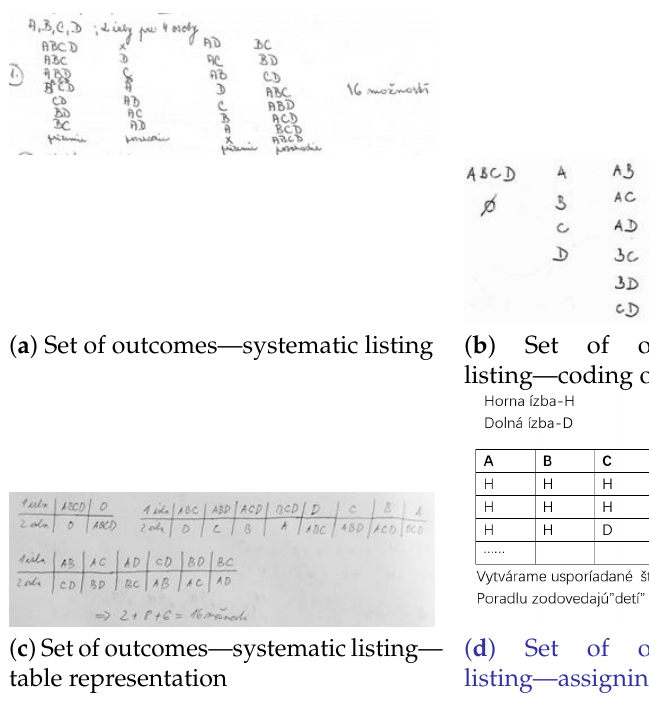
Figure 6. CSS for the MSTs 2.2 Children—Set of outcomes. Another four solutions used counting process (see Figure 7).